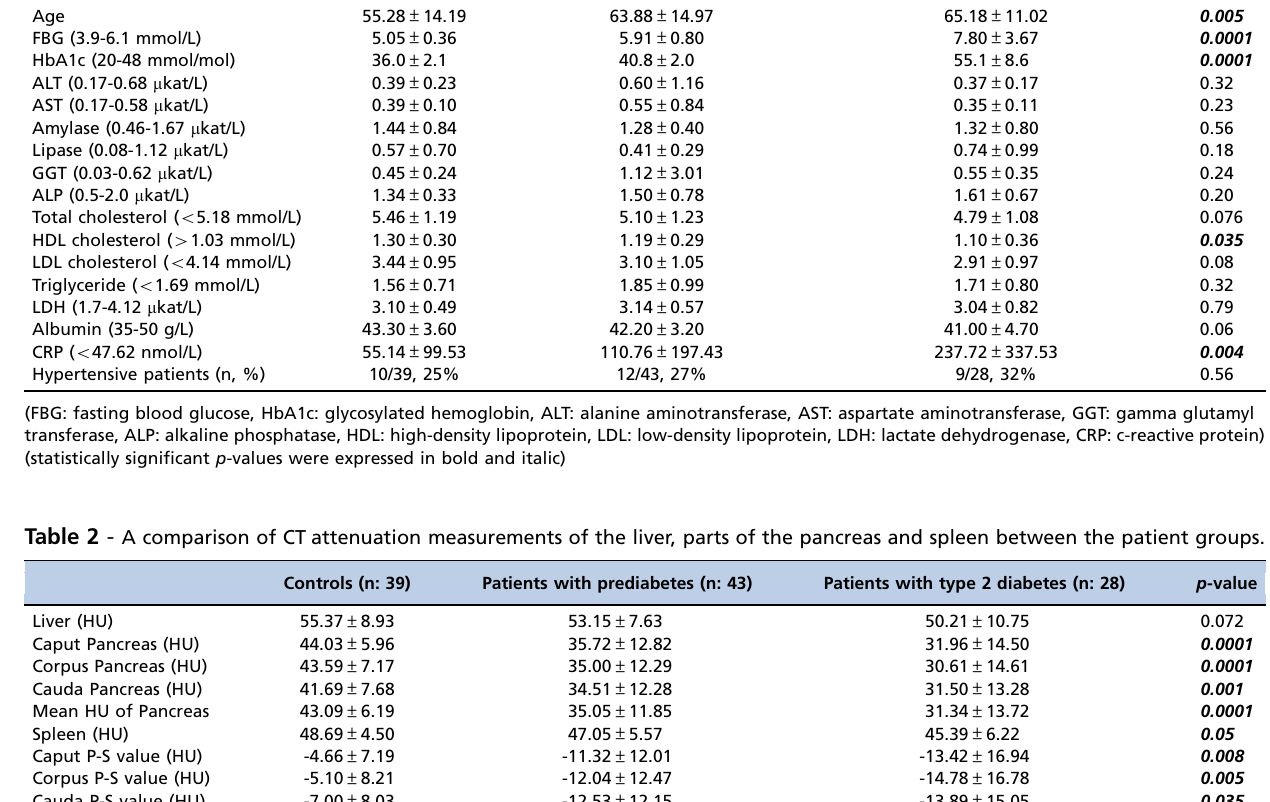
Table 1 - General characteristics and biochemical parameters of the study groups. Parameters (laboratory ranges) Controls (n: 39) Patients with prediabetes (n: 43) Patients with type 2 diabetes (n: 28) p- value